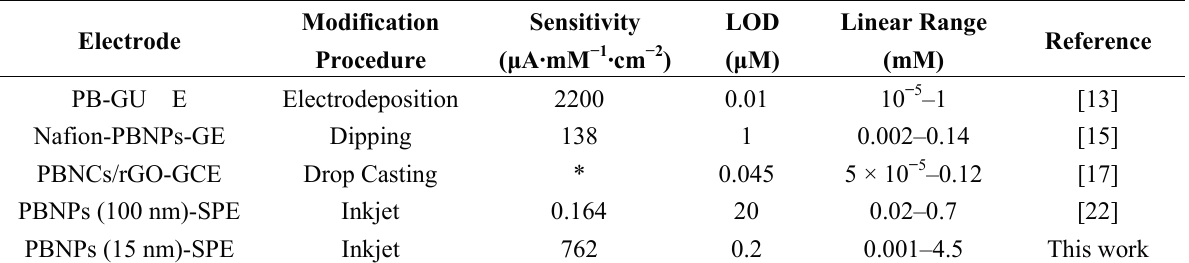
Table 2. Analytical performance characteristics of a number of Prussian blue-modified electrodes for H O 2 2